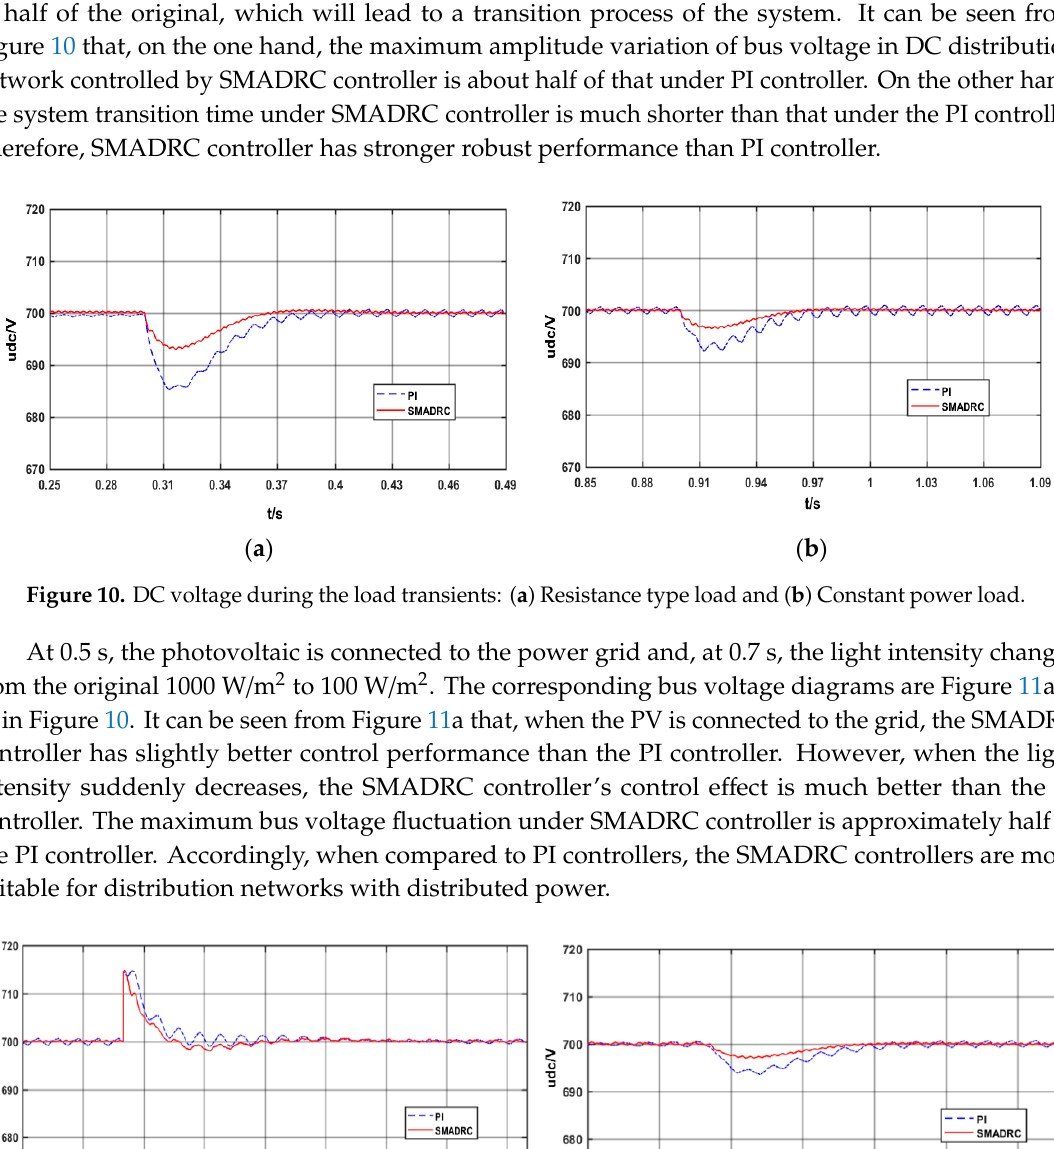
Figure 11. Impact of photovoltaic on bus voltage: ( a ) Photovoltaic connection to the grid and ( b ) Sudden decrease in light intensity.